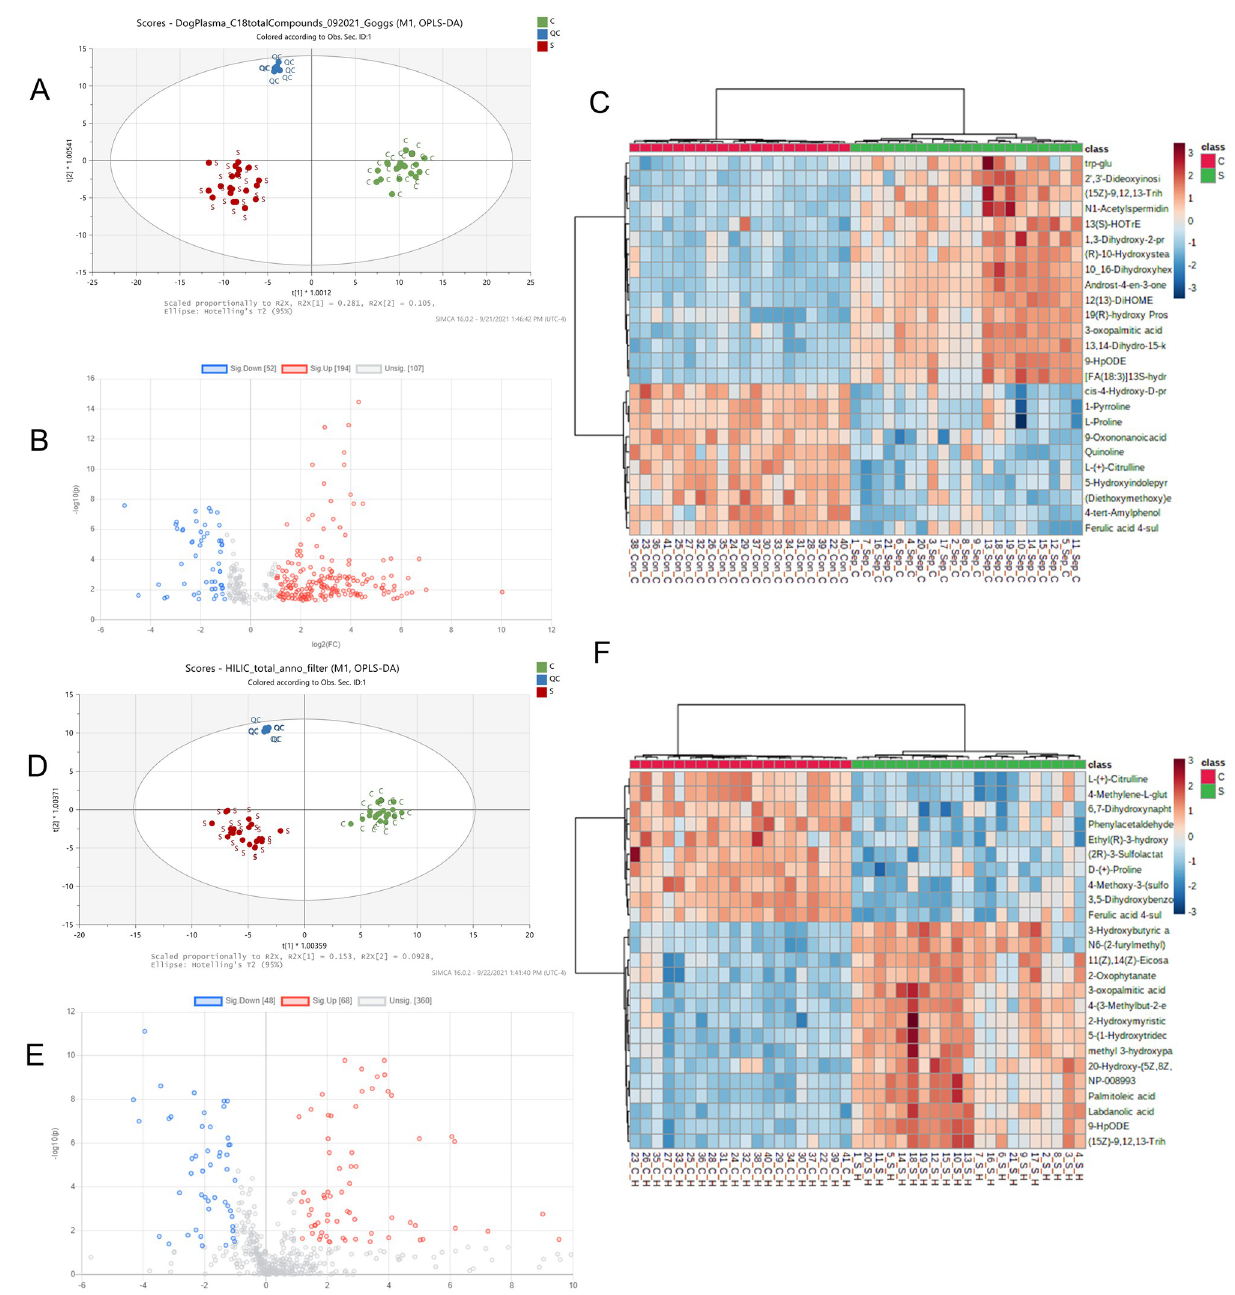
Fig 2. Untargeted metabolomic analyses of plasma samples from dogs with sepsis compared to healthy controls. (A) OPLS-DA plot for C18 metabolites. R 2 X = 0.608, R 2 Y = 0.934, Q 2 = 0.892. (B) Volcano plots for C18 metabolites. P-value < 0.05, FC = S/C. (C) Heatmap: Top 25 significant metabolites in C18 (total 536 unique metabolites in C18 positive and negative modes). (D) OPLS-DA plot for HILIC metabolites. R 2 X = 0.472, R 2 Y = 0.954, Q 2 = 0.879. (E) Volcano plots for HILIC metabolites. P < 0.05, FC = S/C. (F) Top 25 significant metabolites in HILIC (total 386 unique metabolites in HILIC positive and negative